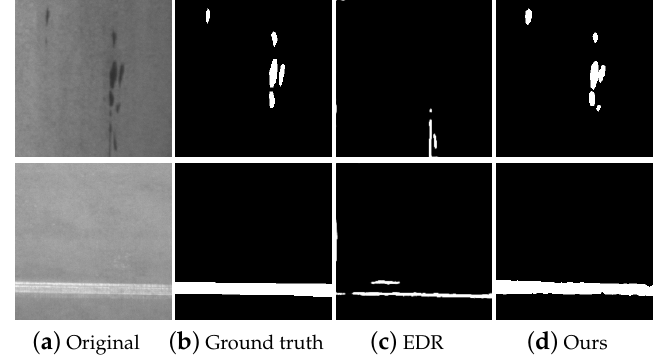
Figure 8. The results of training on CrackForest and testing on